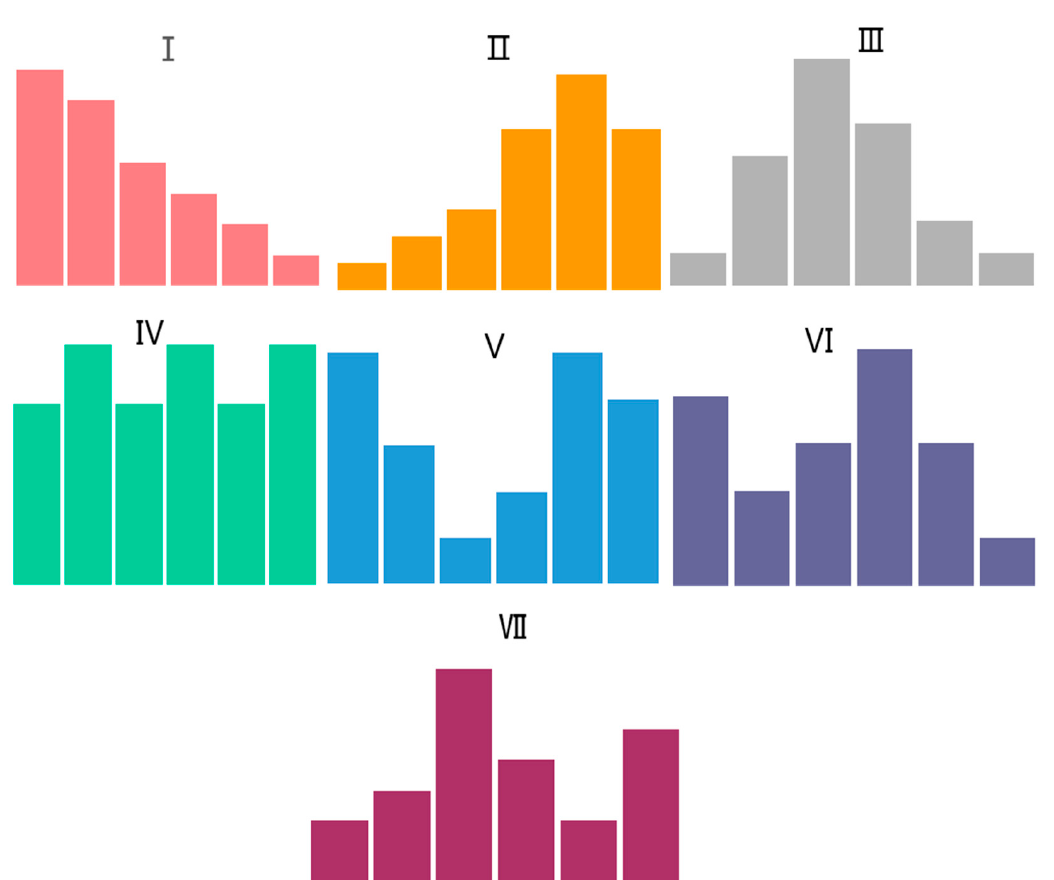
Figure 6. Seven modes of rainfall patterns. Rain pattern ( I ) is a single peak, and the rain peak is located in the front; Rain pattern ( II ) is a single peak, and the rain peak is located at the rear; Rain pattern ( III ) is a single peak, and the rain peak is in the middle; Rain pattern ( IV ) is a uniform rain pattern; Rain pattern ( V ) is bimodal, and the rain peaks are located at the front and rear; Rain pattern ( VI ) is bimodal and the rain peak is located at the front and in the middle; Rain pattern ( VII ) is bimodal and the rain peak is located in the middle and at the rear.